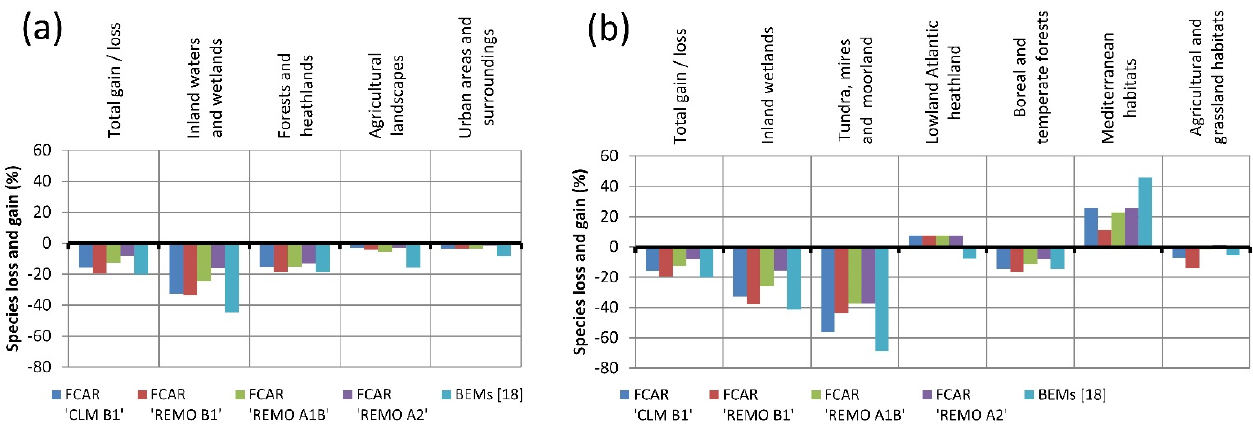
Figure 7. Relative gains and losses of species in the FCARs and in Huntley et al. [18] (as modeled for the LHR) in relation to habitat types ( a ) according to Schröder et al. [42] and ( b ) according to Tucker and Evans [43].